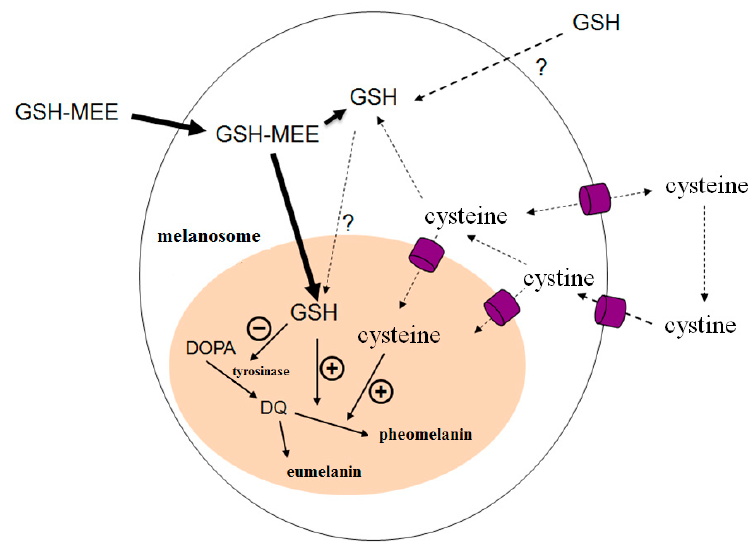
Figure 4. Possible effects of GSH-MEE, GSH, and cysteine on melanogenesis. GSH synthesize intracellularly and exported to extracellular space. Cellular uptake of GSH itself is not probable. GSH-MEE cross the biological membranes by simple diffusion and metabolize intracellularly to generate GSH. Cysteine is readily transported across cell membranes but potentially toxic at high concentrations due to generation of reactive oxygen species and depletion of pyridoxal phosphate. GSH-MEE (but not GSH itself) could suppress the melanin production and tyrosinase activity and raise the suggested pheomelanin/eumelanin ratio. black arrows, melanin synthesis process flow; dotted black arrows, transport process flows of GSH, cysteine, and cysteine, bold black arrows, transport process flow of GSH-MEE; question marks, not yet confirmed; +, positive effects (activation); − , negative effects (suppression); purple shape, membrane channel. GSH, reduced glutathione; GSH-MEE, GSH monoethyl ester; DOPA, dihydroxyphenylalanine; DQ, dopaquinone.